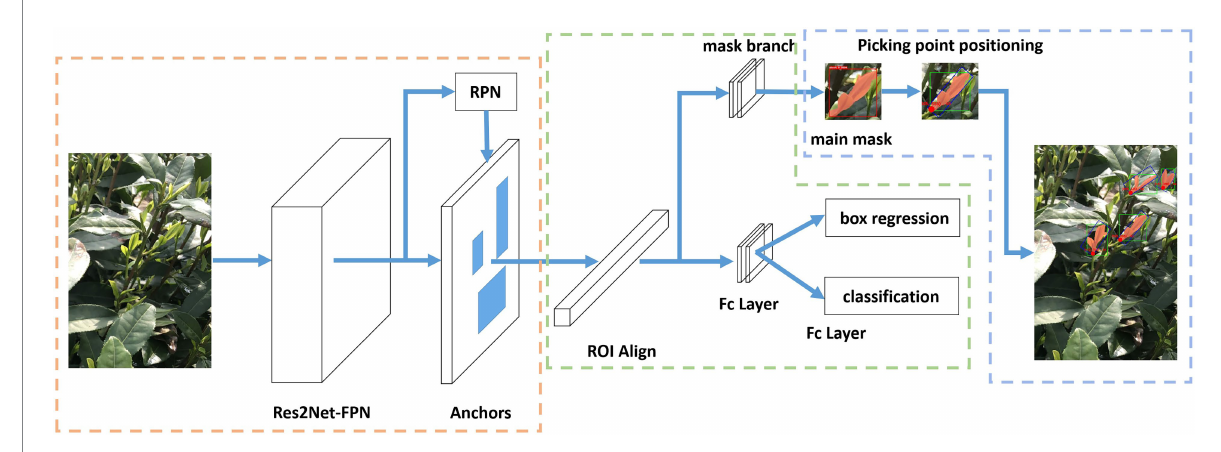
FIGURE 3 Schematic overview of the complete Mask R-CNN Positioning of Picking Point for TeaShoots (MR3P-TS) model